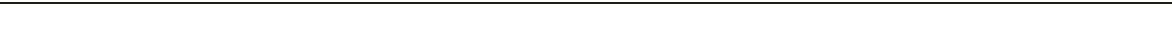
Fig. 5 Repression of BAT paternal monoallelic gene expression by the lincRNA H19. a Plot of expression fold-changes of maternally expressed genes (MEGs) in BAT versus a scWAT b vWAT. c Plot of expression fold-changes of paternally expressed genes (PEGs) between BAT versus c scWAT d vWAT. A Wilcoxon matched-pairs signed rank test was used to assess statistical signi fi cance for up- or downregulation of PEGs/MEGs ( e ) UCSC Genome Browser showing PEG abundances in BAT, scWAT, and vWAT. f , g Expression of indicated PEGs ( f ) or MEGS ( g ) in BAT 1° adipocytes transfected with scr or H19 LNA. f , g A paired, two-tailed Student ’ s t -test was used to assess signi fi cance across n = 4 experiments, n = 3 technical replicates each. h GSEA showing downregulation of PEGs but not MEGs (list from www.geneimprint.com) during 1°BAT differentiation. i , j Cumulative distribution frequency (left) and abundances (right) of PEGs in i 1°BAT and j 1°vWAT in siCtrl transfected adipocyte progenitors at d0 (black) versus differentiated siCtrl (blue) and